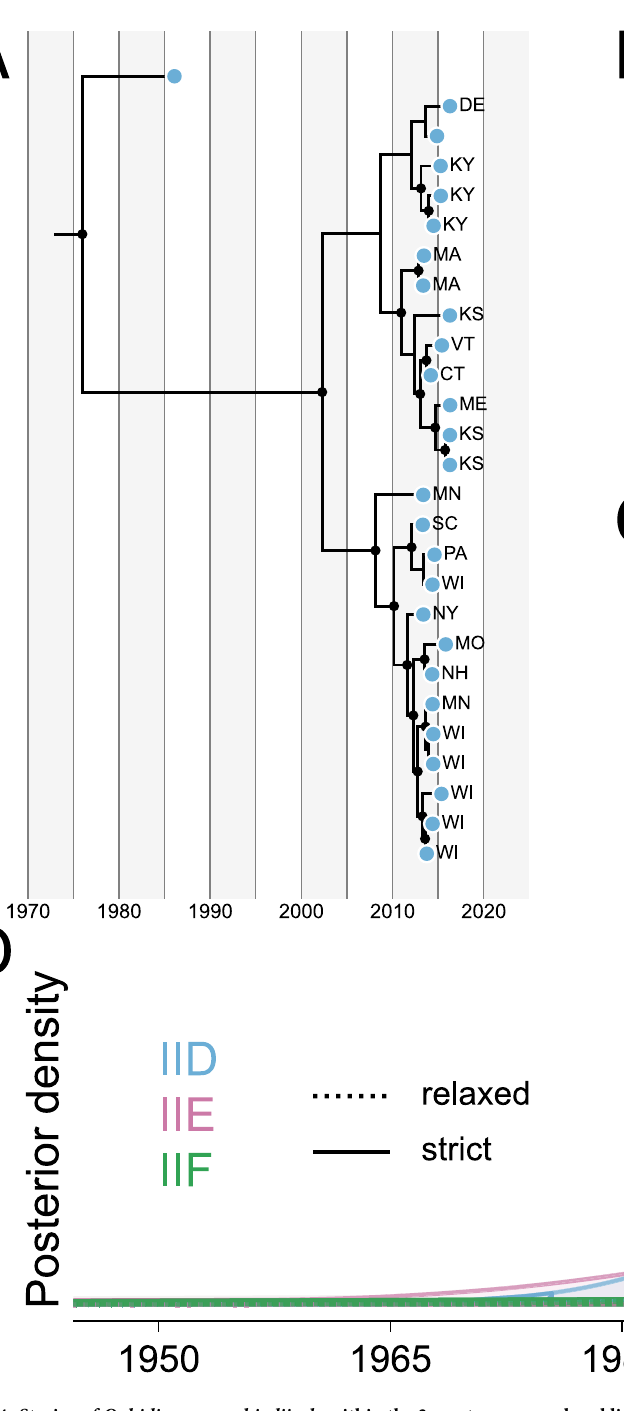
PLOS Biology | https://doi.org/10.1371/journal.pbio.3001676 June 23,